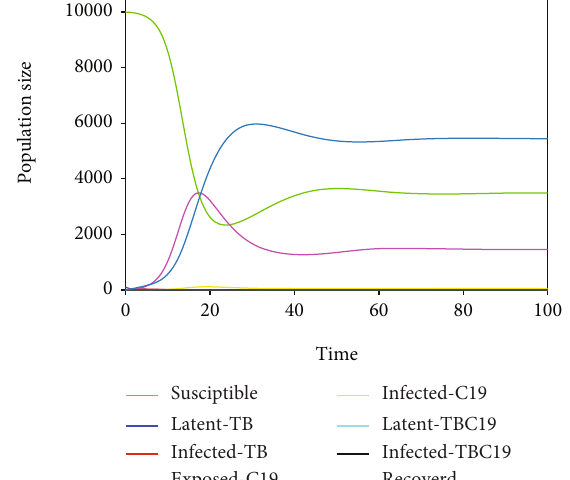
Figure 11: The dynamics of I legend and other parameter values are given in Table